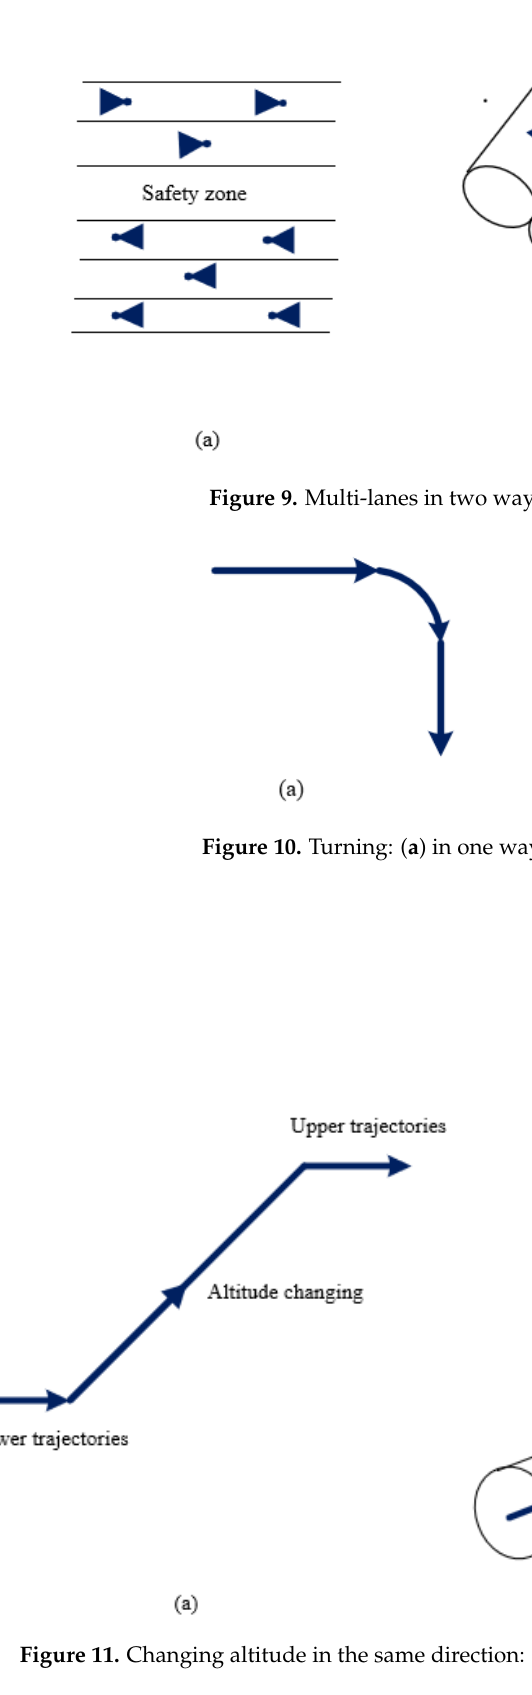
Figure 8. Multi-lanes in one direction: ( a ) vertical view, ( b ) 3D view: v- vertical safe distance, h- horizontal safe distance.